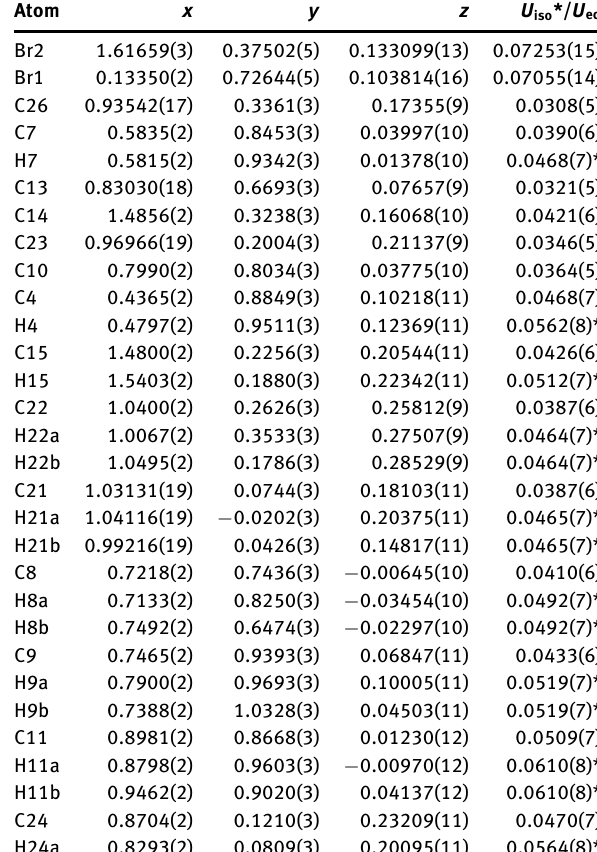
Table 2: Fractional atomic coordinates and isotropic or equivalent isotropic displacement parameters (Å 2